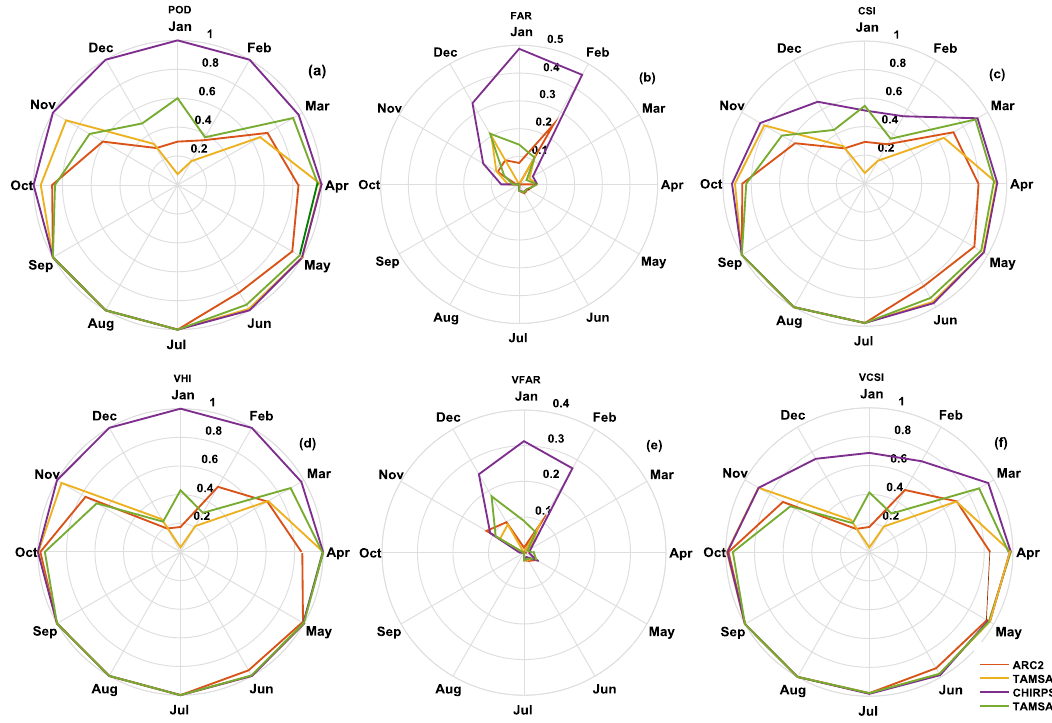
Figure 9. Categorical and volumetric validation of the satellite products for each month of the Upper Blue Nile basin for the period of 2000–2015: (a) probability of detection (POD), (b) false alarm ratio (FAR), (c) critical success index (CSI), (d) volumetric hit index (VHI), (e) volumetric false alarm ratio (VFAR), and (f) volumetric critical success index (VCSI).